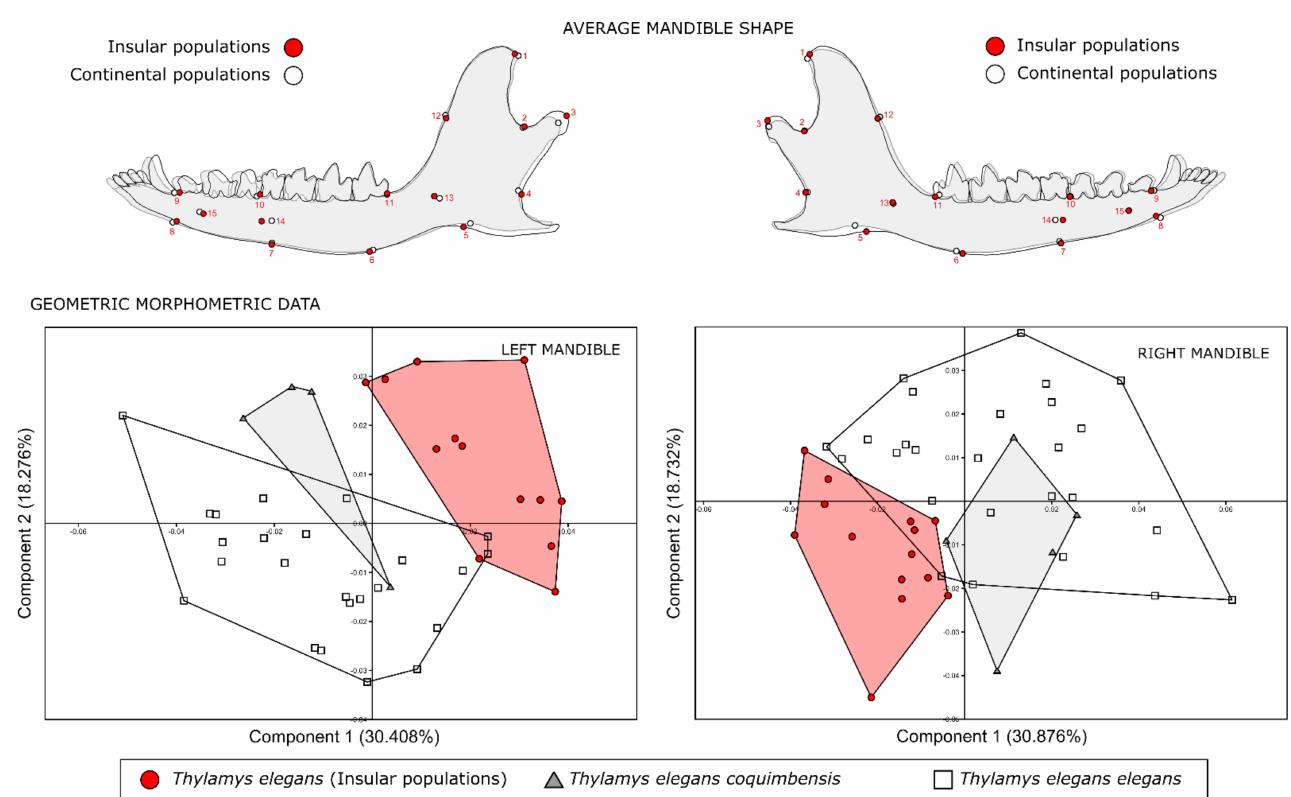
Figure 3. ( Left ) and ( Right ) Average mandible shapes of insular and continental populations of Thylamys elegans and their corresponding Principal Component Analysis. Legend: red circles, insular populations of Thylamys elegans ; grey triangles, Thylamys elegans coquimbensis ; white squares, Thylamys elegans elegans